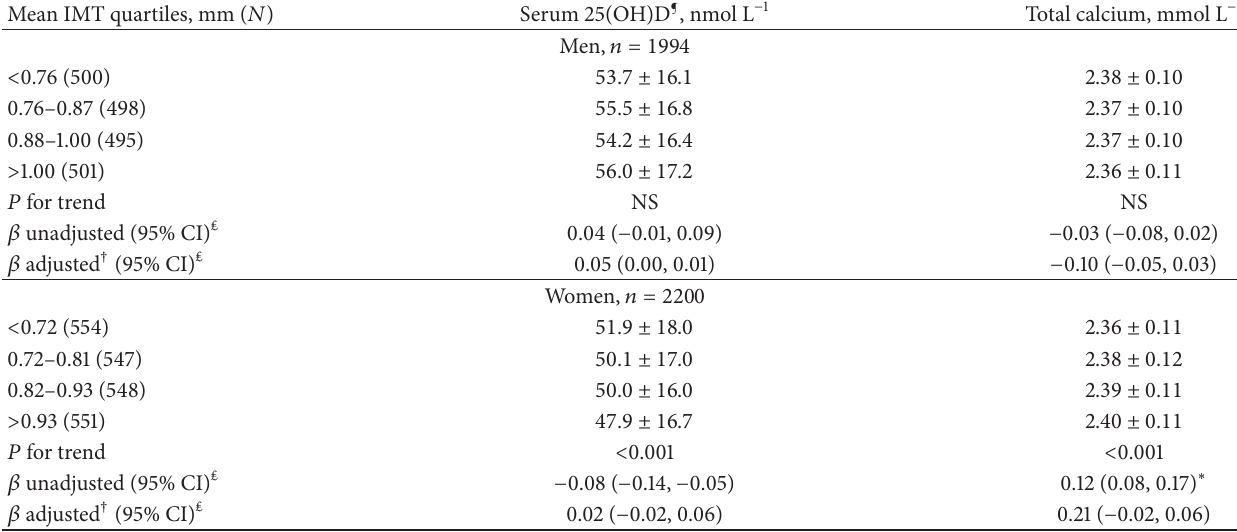
Table2:Serum25(OH)D(means ± SD)inquartilesofmeanIMTinmenandregressioncoefficients (𝛽) withtheirrespective95%confidential intervals from linear regression models. The 4th Tromsø Study, 1994-1995.